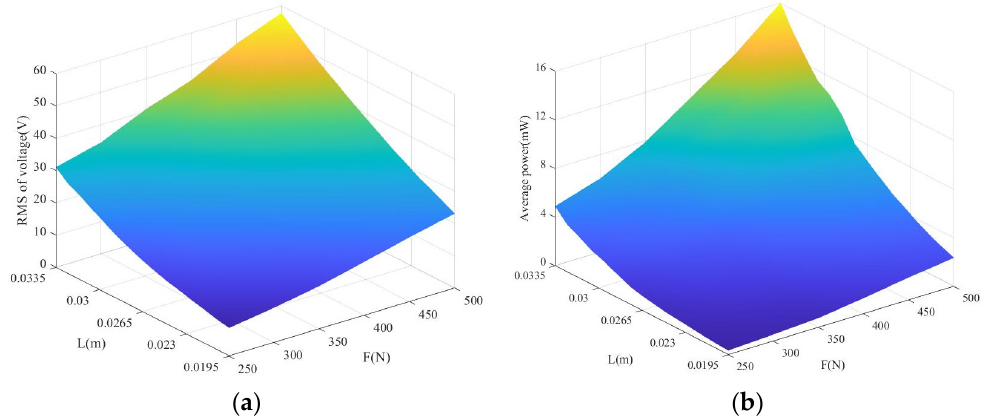
Figure 21. RMS of voltages and average powers from 1#1 PZT4 patch of 1# piezoelectric brick with Babbitt metal substrate versus the force arm length of LPCB and the footstep excitation amplitude. ( a ) RMS of voltages; ( b ) Average powers.